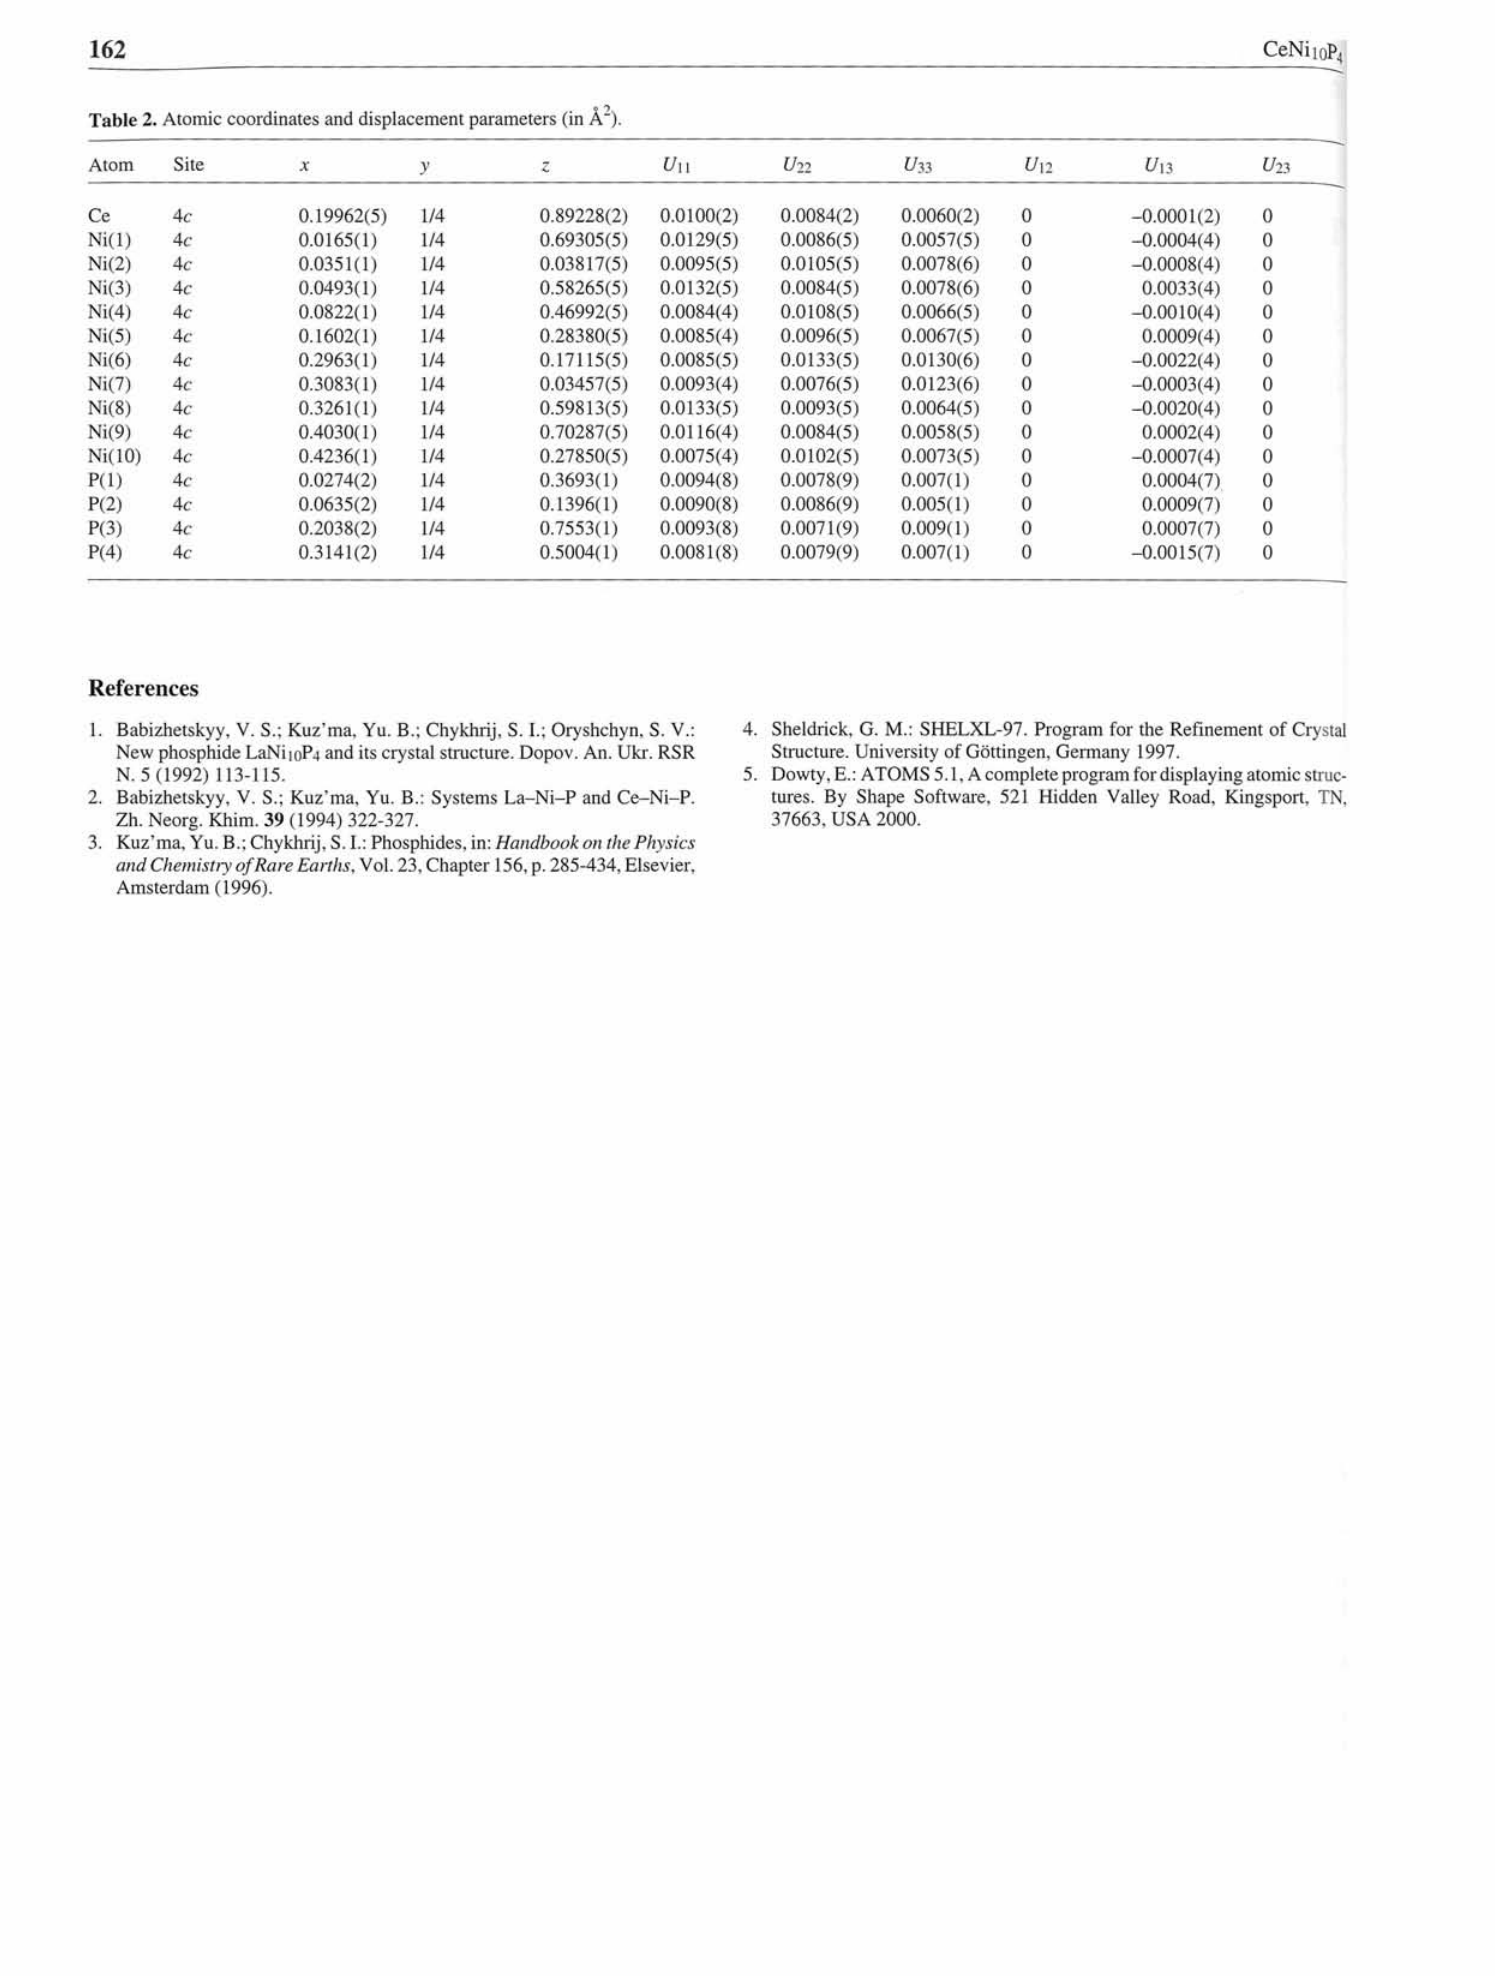
Table 2. Atomic coordinates and displacement parameters (in Á 2